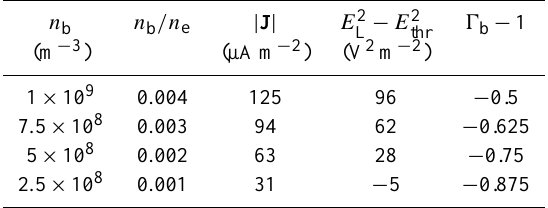
Fig. 1. Area over the v b /1v b - n b /n e plane for which both equations (Eqs. 4 and 5) ensure LBI and Langmuir decay. The area of Lang- muir decay is increased when α 0 is increased ( 1v b is increased).